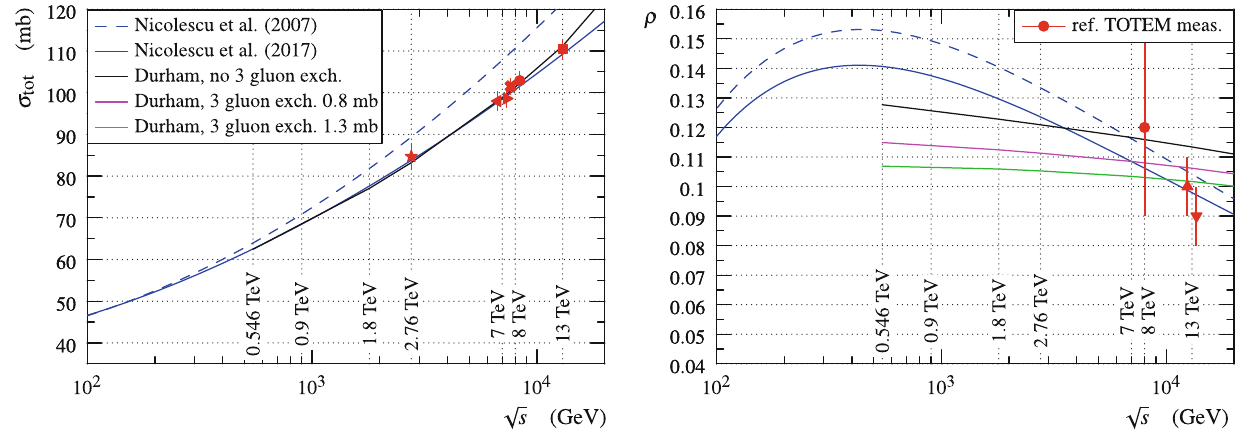
point to the fit with N b = 3 and | t | max = 0 . 15GeV 2 , the right point to N b = 1and | t | max = 0 . 07GeV 2 .FortheDurhammodeltheblackcurve corresponds to the prediction without a colourless 3-gluon t -channel exchange. The magenta and green curves refer to the pp predictions including a 3-gluon exchange with proton coupling equivalent to 0 . 8 and 1 . 3mb,